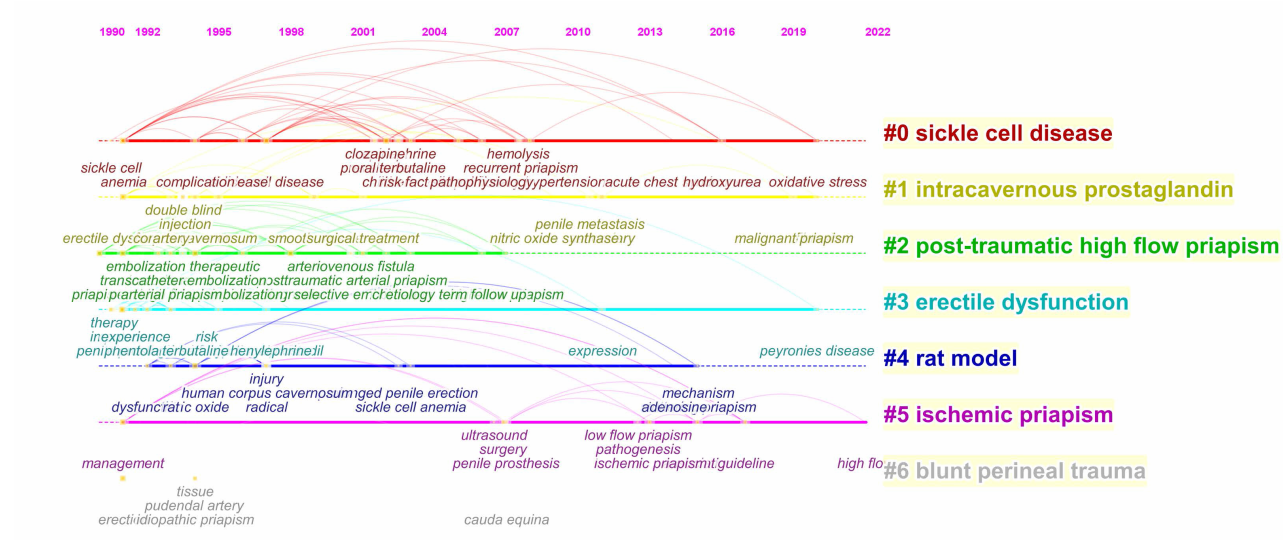
FIGURE 6. The timeline view of the knowledge map in priapism field. This view clearly presents the stage of the research in the appearance time point and time span of 7 clusters.